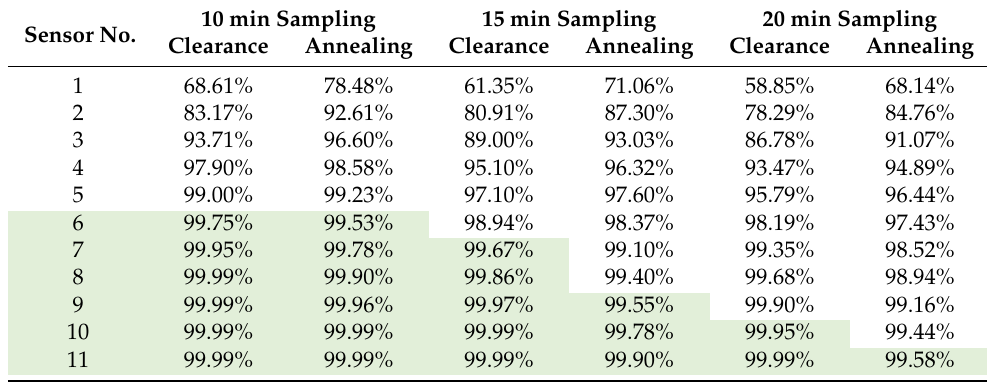
Table 1. Safety factors as a function of sampling frequency and number of sensors [16]. Sensor